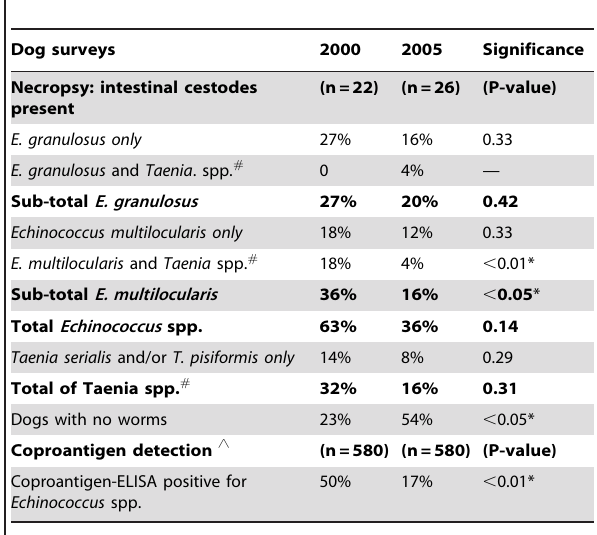
Table 1. The prevalence of Echinococcus granulosus in dogs determined by necropsy and coproantigen surveys in 2000